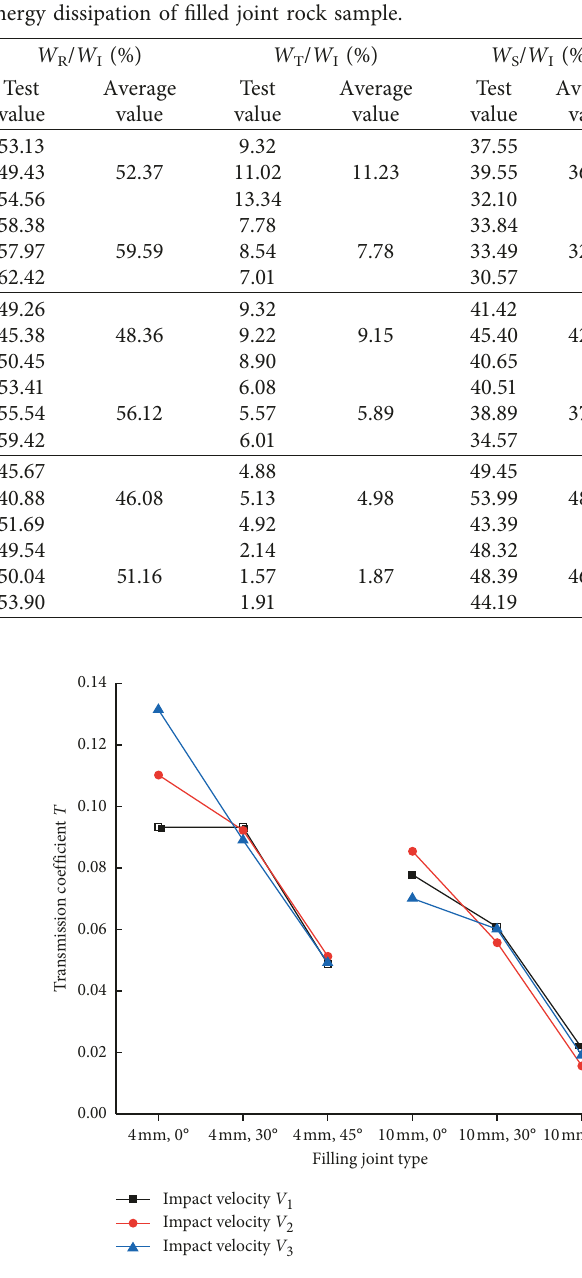
Figure 9: Transmission coefficient variation curve of filling joint types under three impact